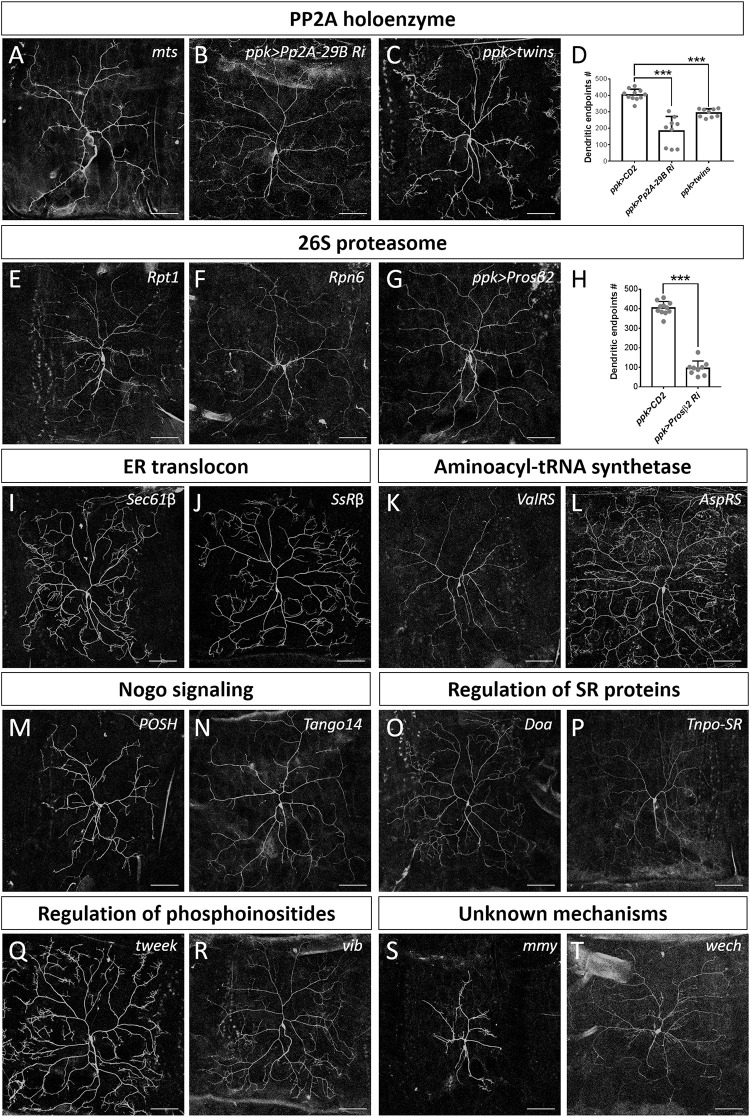
Dendrite regulators acting in conserved complexes or pathways. (A–D) Components of PP2A holoenzyme are required for dendrite morphogenesis. Dendritic arborization of mtss5286 c4da MARCM clones is shown (A). Dendritic arborization of Pp2A-29B-RNAi
(B) and twins-overexpressing (C) c4da neurons was visualized with mCD8::GFP driven by ppk-GAL4. Quantification of numbers of dendritic endpoints in c4da neurons of the indicated genotypes is shown in (D). (E–H) The 26S proteasome is required for dendrite morphogenesis. Dendritic arborization of Rpt1k11110
(E) and Rpn6k00103
(F) c4da MARCM clones is shown. Dendritic arborization of Prosβ2-RNAi c4da neurons was visualized with mCD8::GFP driven by ppk-GAL4
(G), and dendritic endpoints were enumerated (H). (I–T) Representative c4da MARCM clones of indicated mutants. Alleles used were Sec61βk03307
(I), SsRβs1939
(J), ValRSk14804
(K), AspRSKG03912
(L), POSHk15815
(M), Tango14k00619
(N), Doas2784
(O)
Tnpo-SRKG04870
(P), tweekEY20585
(Q), vibj7A3
(R), mmyKG08617
(S), and wechk08815
(T). Scale bars = 100 μm. Student’s t-test P values (***P < 0.001).